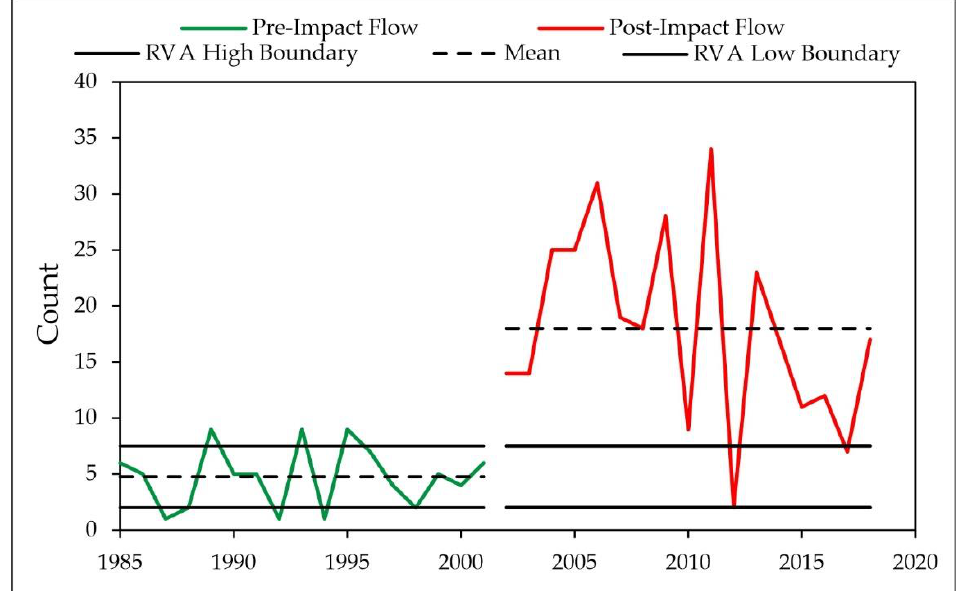
Figure 9. Hydrologic alteration of low pulses at Širvinta-Liukonys WGS. The parameters of group 5 experienced the largest alterations. Variation of the rise rate values was from − 61.5% (at Bartuva- Skuodas WGS) to 22.2% (at Mūša -Ustukiai), the fall rate was from −66.7% (at Verknė - Verbyliškės) to 8.3% (at Šušvė -Josvainiai), and the number of reversals was from − 100% to 9.1%. The values of the number of reversals fell outside the defined RVA ranges in 90% of the years in the post-impact period (at Bartuva- Skuodas, Jūra - Tauragė, Širvinta -Liukonys); all of these values fluctuated outside the target range at Mūša - Ustukiai and Šušvė -Josvainiai WGSs (i.e., alteration of − 100%, Figure 10). In this study, the number of reversals was identified as an indicator of the most dramatic change in hydrologic alteration. The alterations of the rise and fall rate values were low to moderate. In general, the variation of parameters of group 5 was the most shifted at Bartuva- Skuodas (by 65%), Mūša - Ustukiai (by 56%), and Lėvuo -Bernatoniai WGS (by 54%), in absolute values.